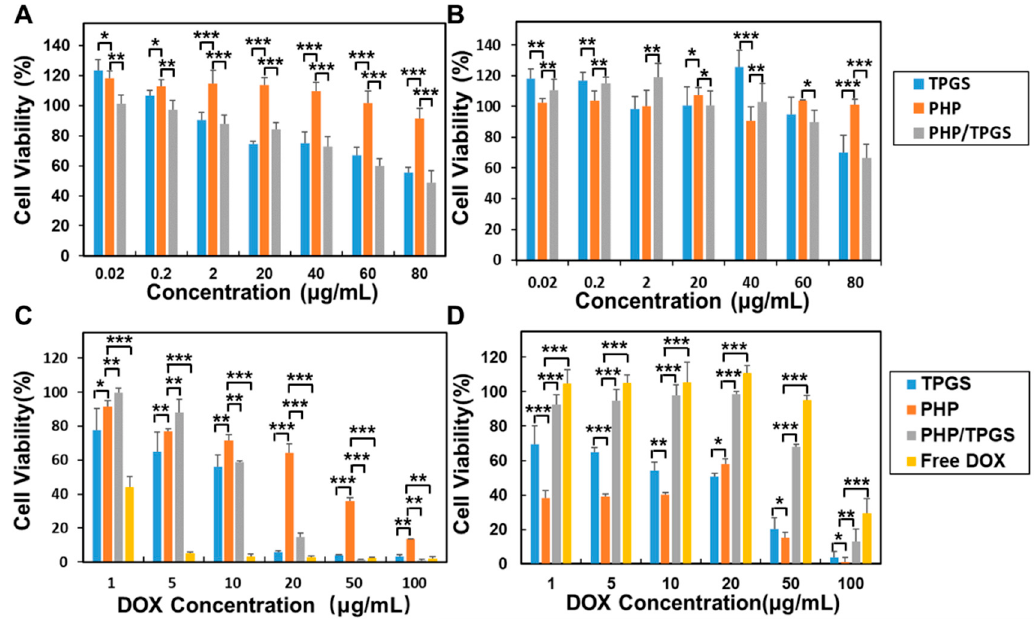
Figure 9. The cytotoxicity of MCF-7 ( A ) and MCF-7/ADR ( B ) cells incubated for 24 h with blank PHP, TPGS, or PHP:TPGS = 1:1 co-polymeric micelles as a function of polymer concentrations and the cytotoxicity of MCF-7 ( C ) and MCF-7/ADR ( D ) cells treated by free DOX, or DOX-loaded PHP, TPGS, PHP:TPGS = 1:1 co-polymeric micelles as a function of DOX concentrations. Data as mean ± SD ( n = 6). * p < 0.05, ** p < 0.01, *** p < 0.001.